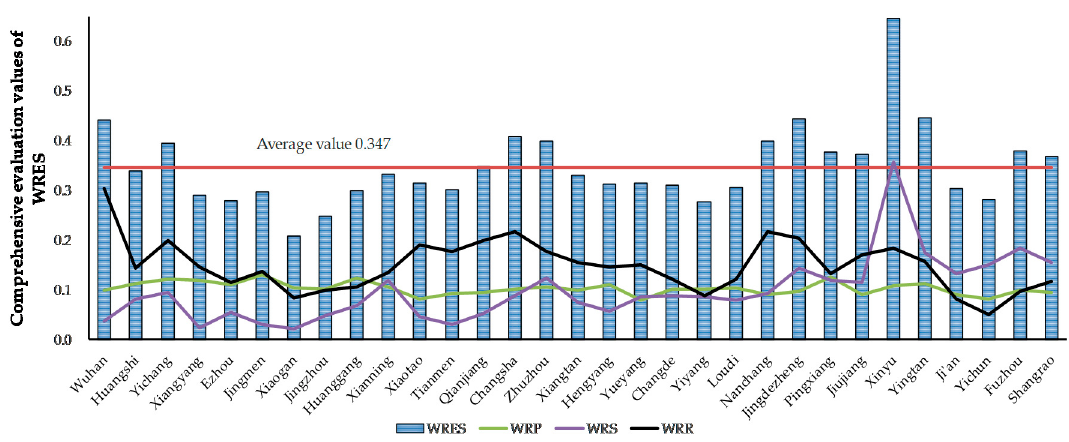
Figure 4. Average comprehensive evaluation values of the WRES from 2008 to 2017.